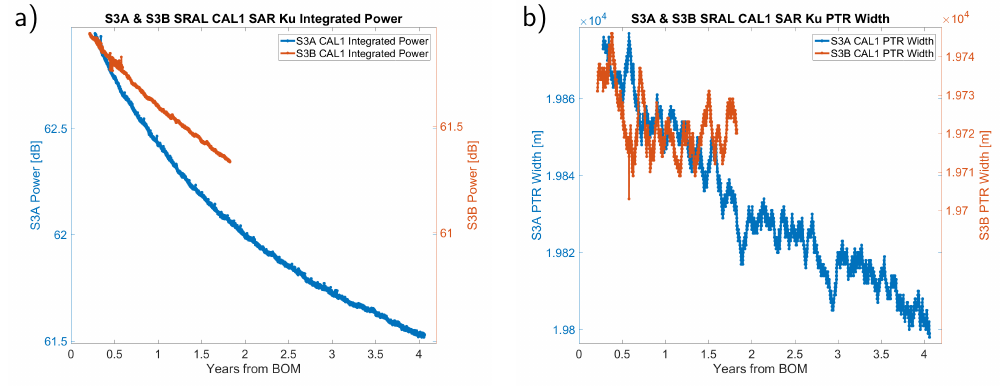
Figure 5. Complete mission series of S3A and S3B SRAL instrumental corrections for ( a ) emitted power, and ( b ) CAL1 PTR width.